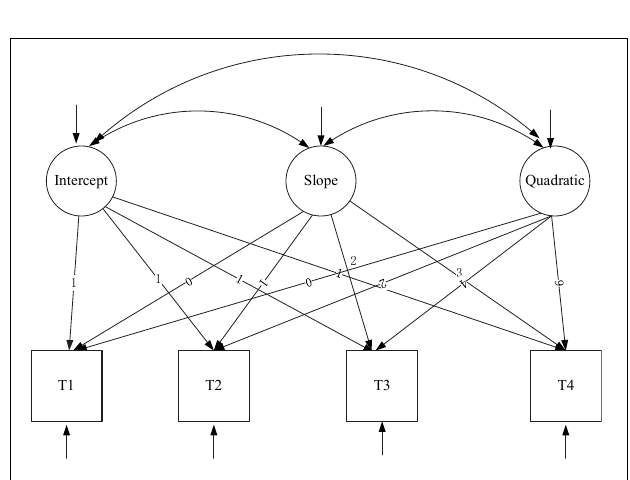
FIGURE 4 | Non-linear unconditional latent variable growth model.